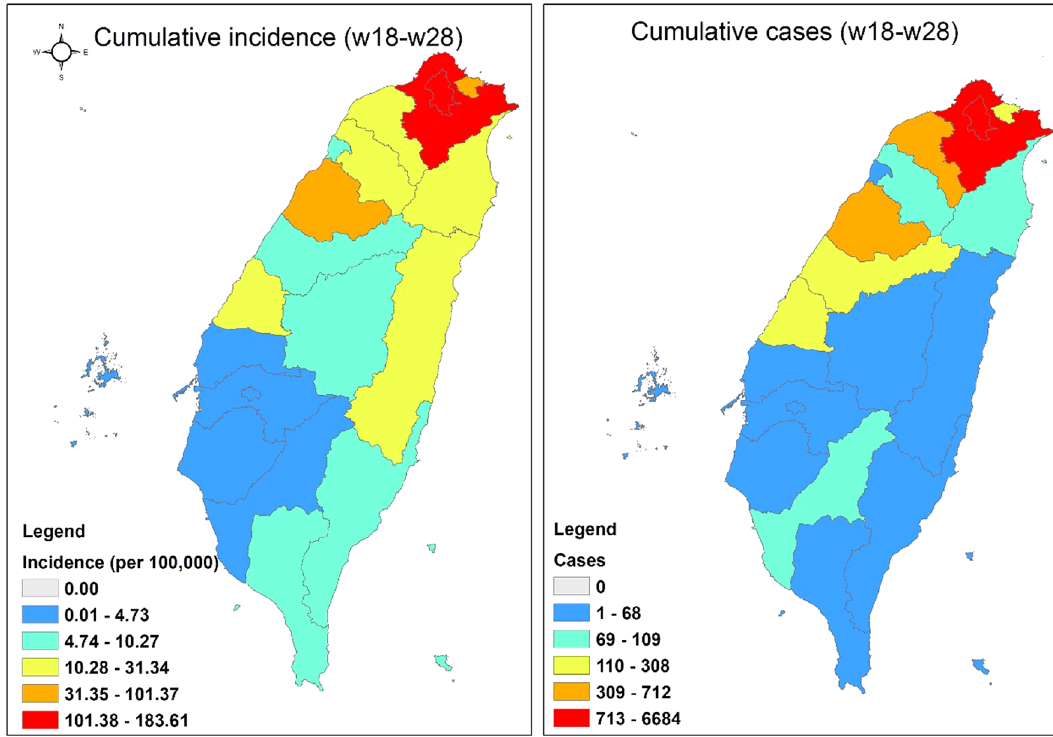
Figure 1. Cumulative incidence and cases of indigenous COVID-19 cases from week 18 (May 2 to May 8) to week 28 (July 11 to July 17, 2021). The map was created by ArcGIS (ArcMap, version10.3; ESRI Inc., Redlands, CA,